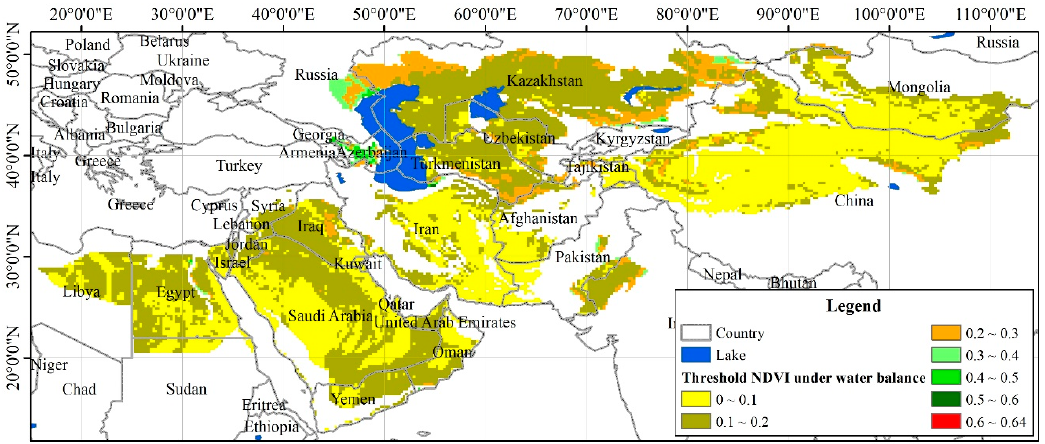
Figure 7. Threshold value of the mean annual NDVI under water balance between 1982 and 2015 over the Silk Road Economic Belt. Table 1. Threshold value of mean annual NDVI and its response to precipitation change under water balance between 1982 and 2015 in different desert areas over the Silk Road Economic Belt.